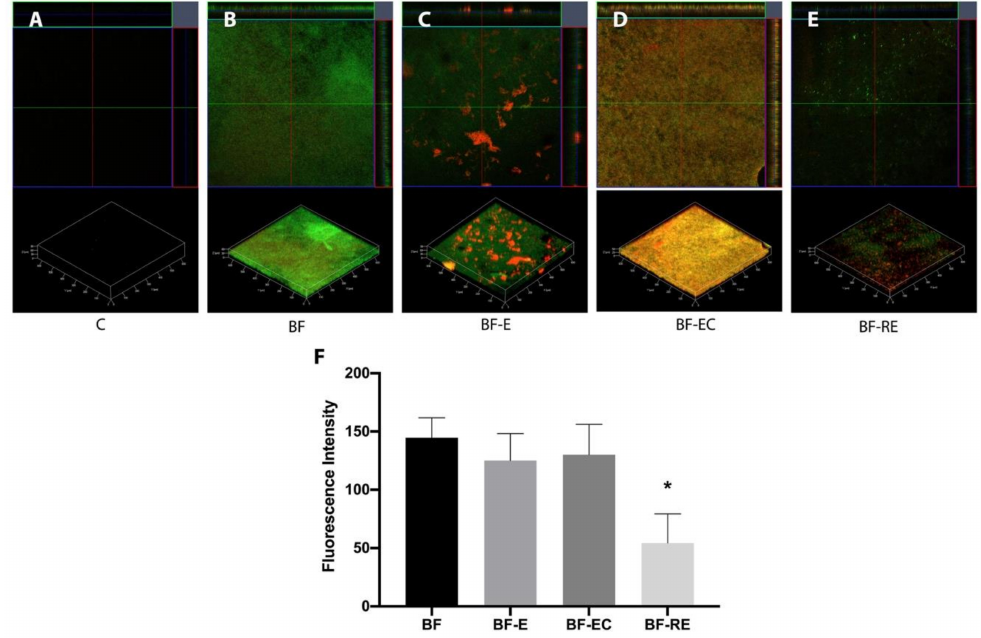
Figure 1. Confocal laser scanning microscopy (CLSM) images of Streptococcus mutans ( S. mutans ) biofilm grown on dentin discs after surface treatment (green and red staining represent live and dead bacterial cells, respectively). ( A ) Control, ( B ) biofilm formation and no surface treatment, ( C ) biofilm formation and treatment with acid etching, ( D ) biofilm formation and treatment with acid etching and chlorhexidine, ( E ) biofilm formation and treatment with pumice prophylaxis and acid etching, and ( F ) fluorescence intensity of the di ff erent experimental groups. The asterisk ( * ) indicates statistically significant di ff erences between the groups ( p <